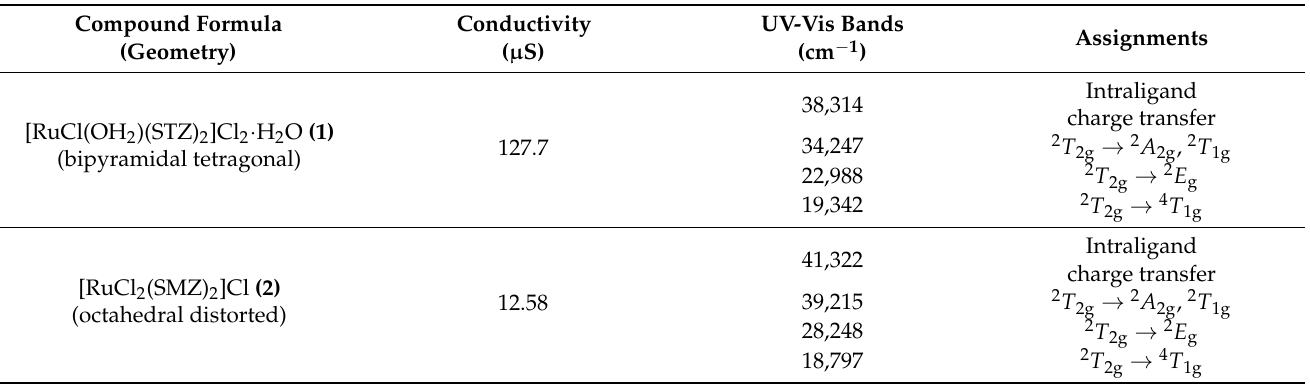
Table 2. Conductivity of solutions in the mixture H 2 O:MeOH ( v / v = 1:1; 1 mM) together with electronic data of complexes’ studied samples